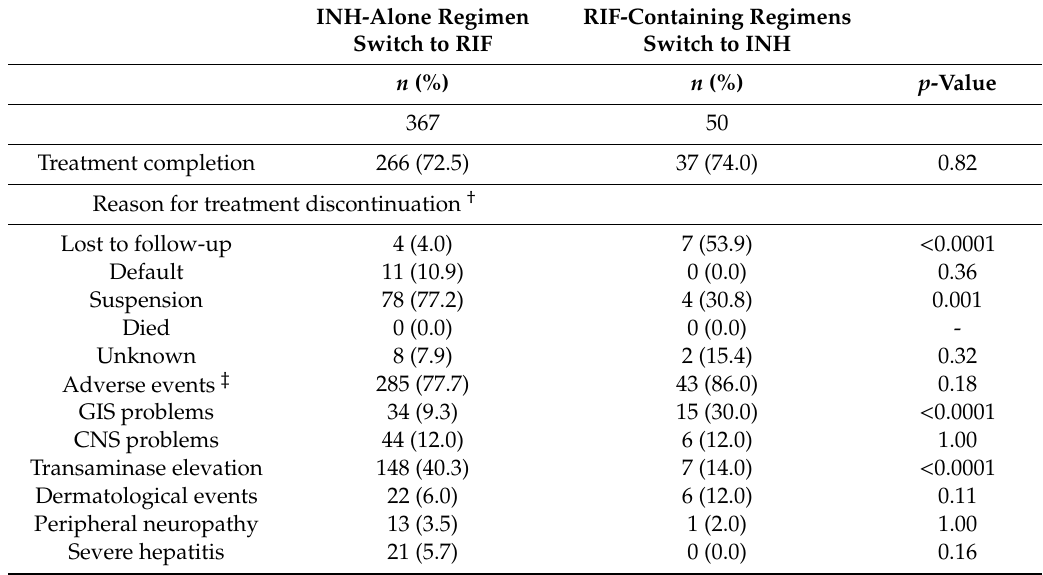
Table 6. Comparison of treatment outcomes and AEs between groups treated with INH-alone and RIF-containing regimens who performed therapeutic changes ( n = 417). INH-Alone Regimen RIF-Containing Switch to RIF